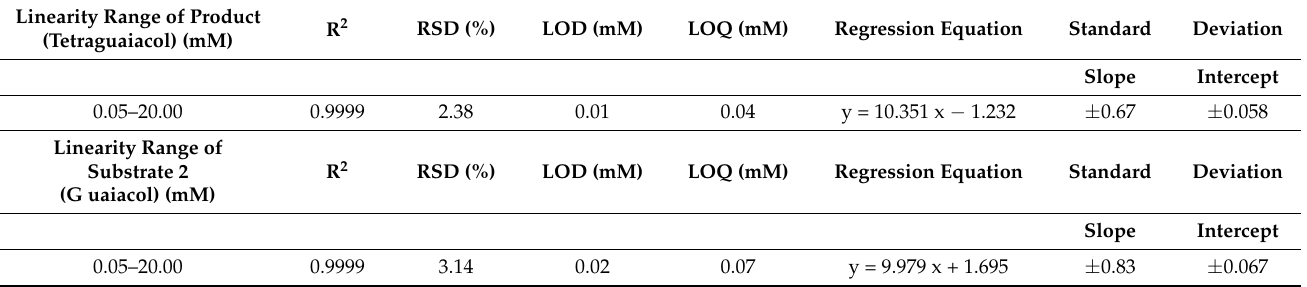
Table 1. Regression equation and quantification for tetraguaiacol and guaiacol for six replicates for each sample ( n = 6) in the concentration range 0.05–20.00